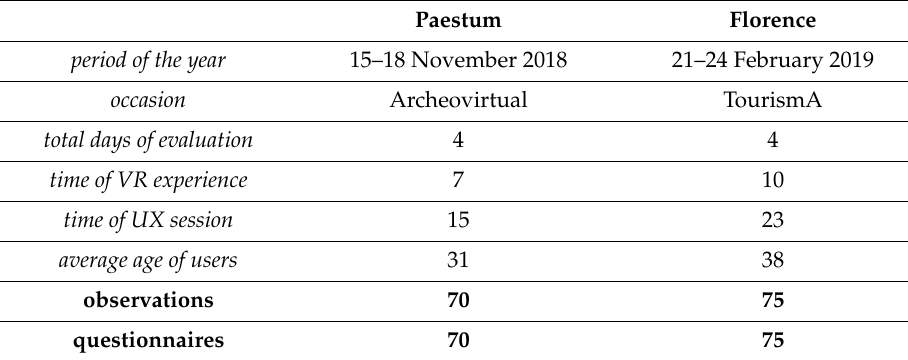
Table 1. Data collected in two occasions of